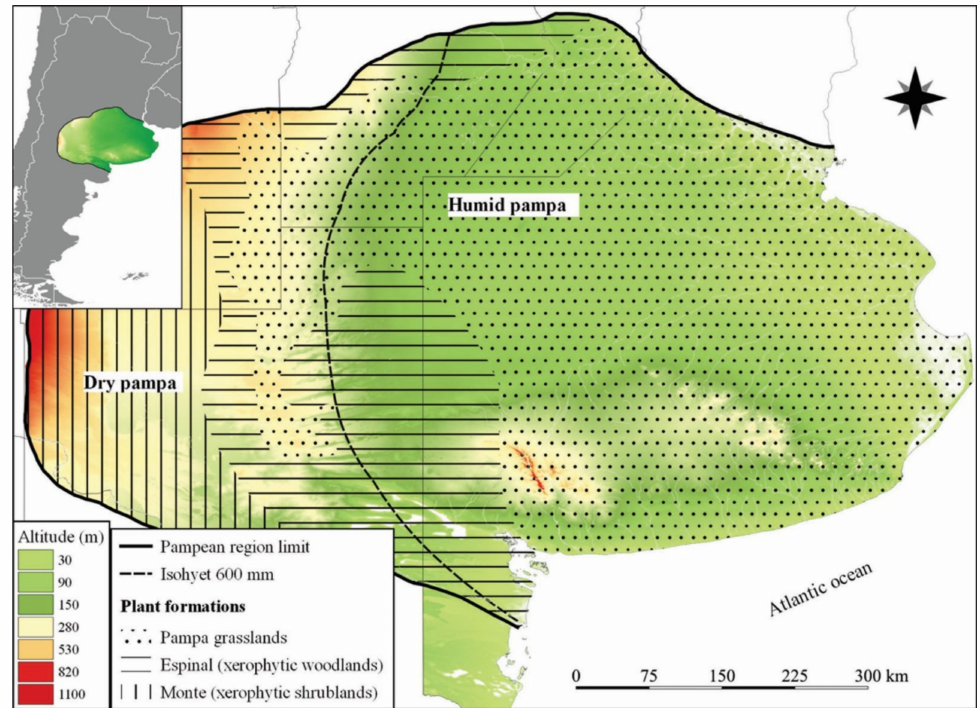
Figure 1. Location of the Pampean Region in